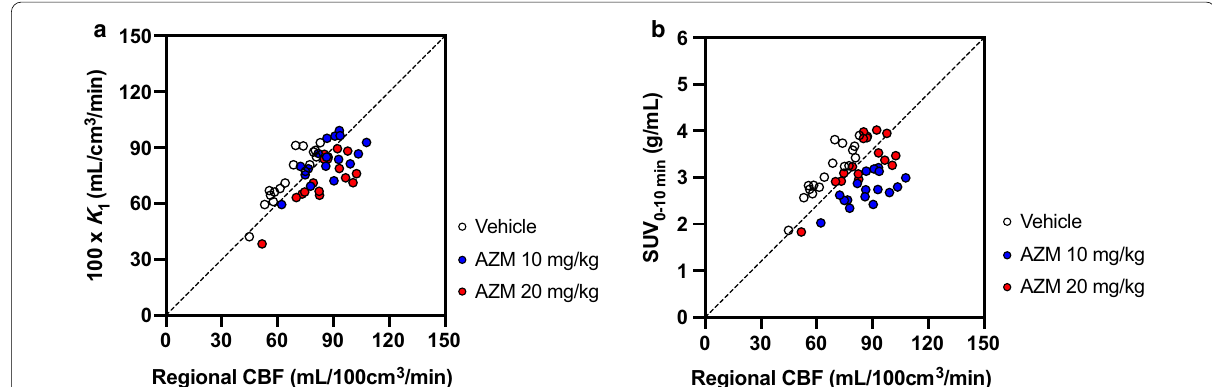
Fig. 5 Comparison of regional CBF values obtained by [ 15 O]H 2 O and K 1 ( a ) and early phase SUV ( b ) of [ 11 C] 4 . K 1 values of ( a ) were multiplied by 100 to align with the units of CBF. Seventeen brain regions were selected for comparison: cerebellum, right and left hippocampus, right and left temporal cortex, hypothalamus, thalamus, right and left occipital cortex, right and left putamen, right and left caudate, right and left frontal cortex, cingulate, and white